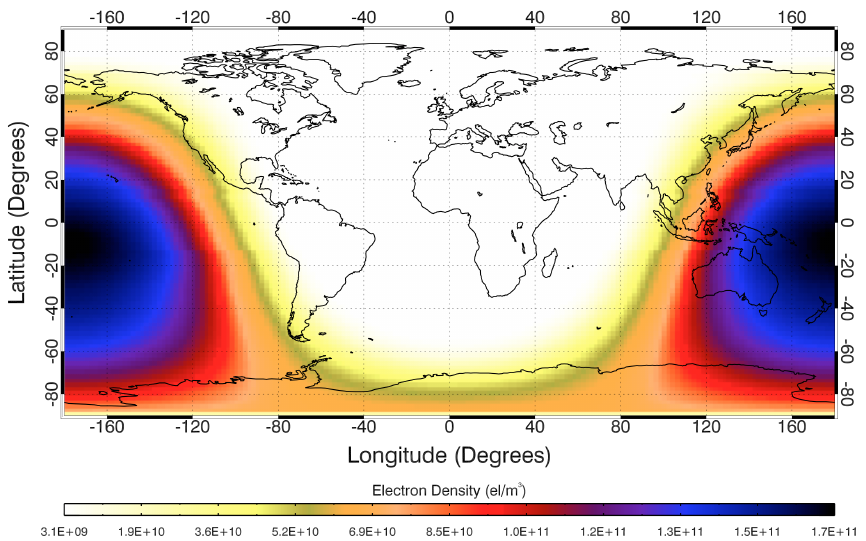
Fig. 5. The global structure of electron density in the Earth’s ionosphere is plotted at an altitude of 100km for the simulated cases shown in Fig. 2a and b. Density is measured in m − 3 at 00:00UT on 1 January. The color bar shows densities that range from high density present during daytime hours to the low densities present at night. Notice the distinct diurnal cycle of high daytime density located at the east/west of the map and the low nighttime density area located at the center of the map. Note that higher electron density inhibits meteor trail